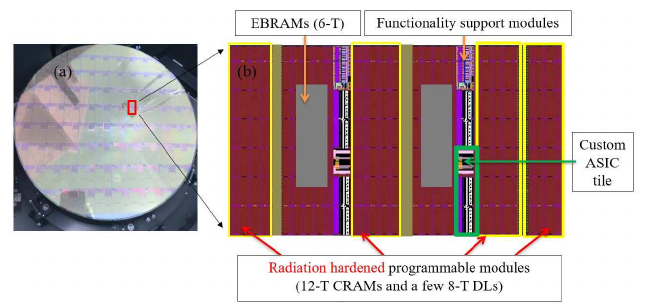
Figure 1. The developed device: ( a ) the 8-inch wafer of designed DUT; and ( b ) the layout and architecture of